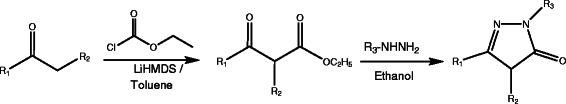
Synthesis of β-keto esters from ethyl chloroformate and its conversion into pyrazolones.